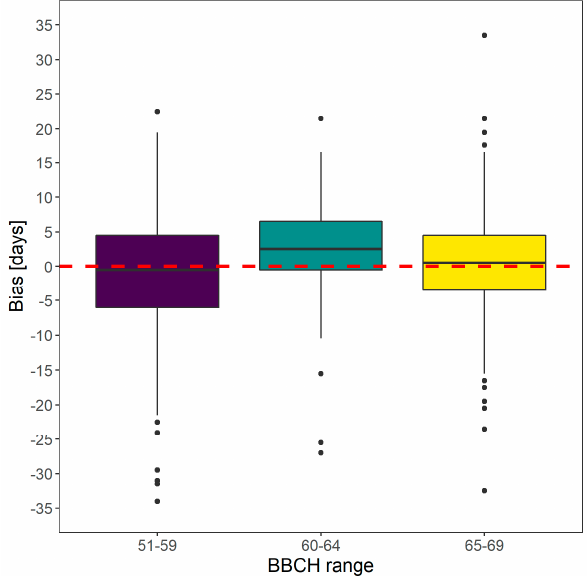
Figure 7. Bias distribution of predicted BBCH DOYs within the main flowering periods, in the calibration analysis.